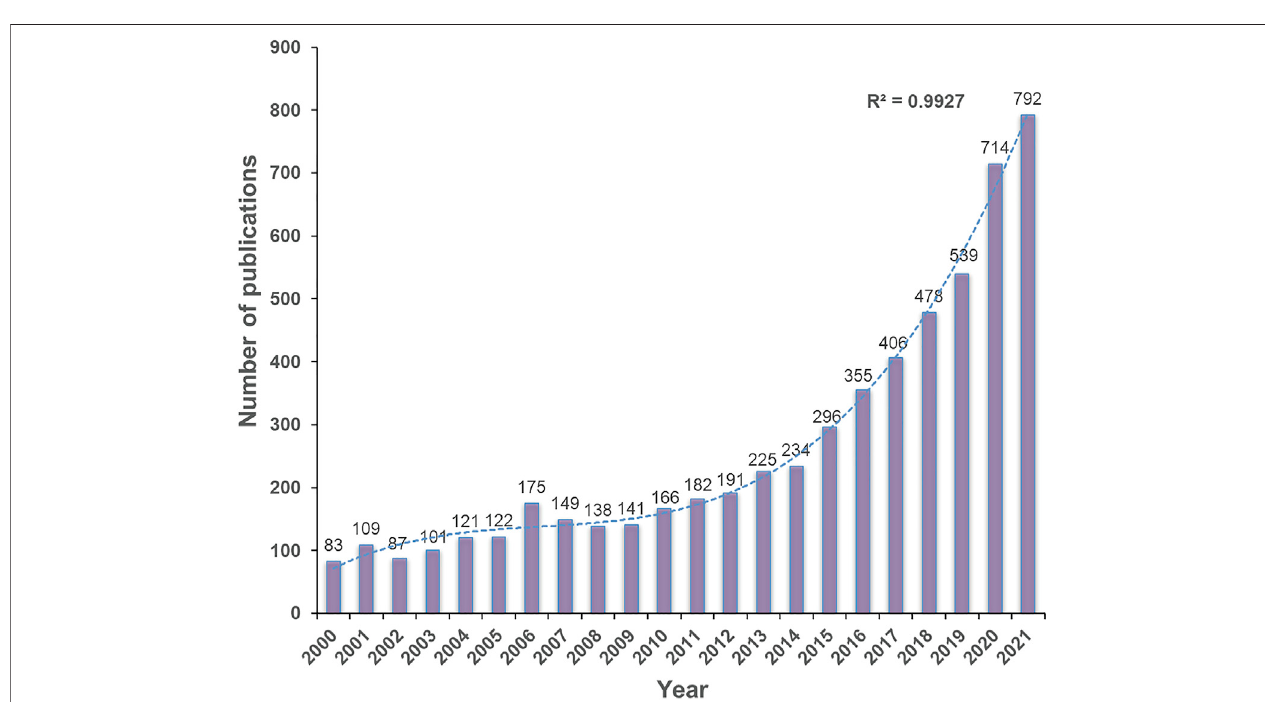
FIGURE 2 | The annual publication trends in the past 22 years. Purple bars represent the number of papers related to CPDT per year. The blue dotted line represents the trend- fi tted curve and the correlation coef fi cients ( R 2 ) is displayed in the fi gure.